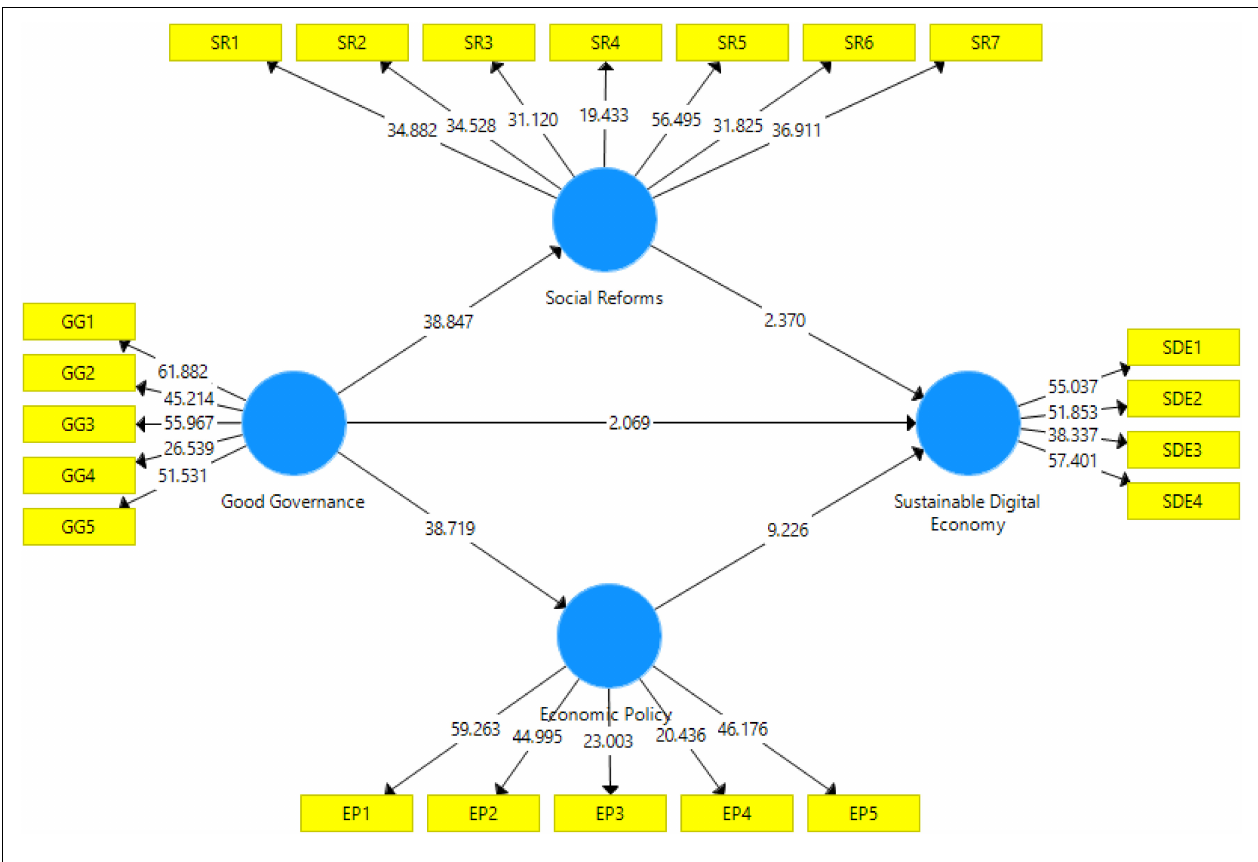
FIGURE 3 | Structural model outcomes. TABLE 5 | Direct and indirect